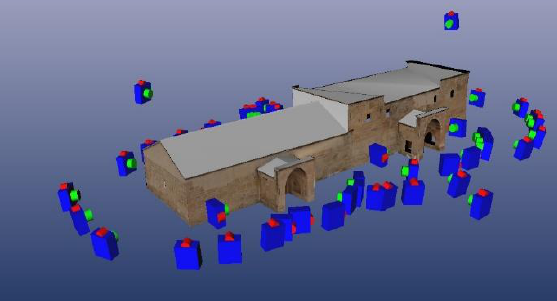
Figure 7. Camera points and Covered surface for